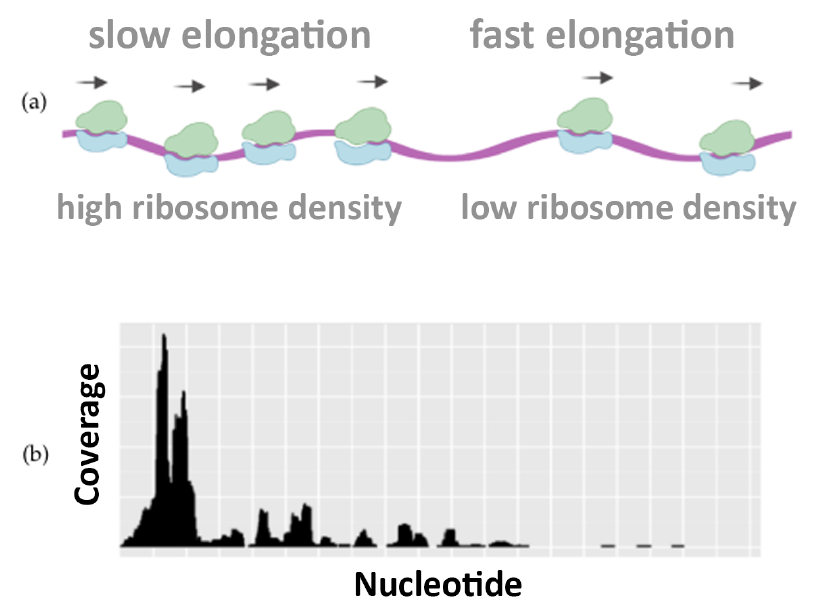
Figure 1. Ribosome footprint density along the mRNA. The schematic distribution of translating ribosomes along the mRNA ( a ) and their ribosome profiles ( b ). Ribo–seq data show differences in the density of ribosomes: regions of fast elongation accumulate fewer ribosomes (low density) with respect to regions of slow elongation (high